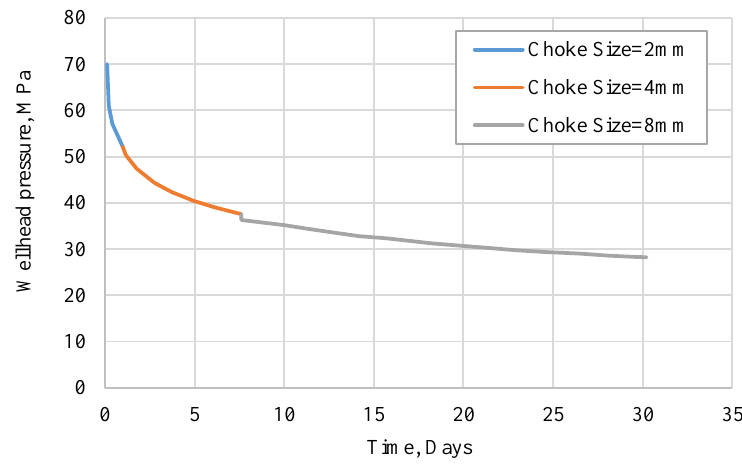
Figure 14—Wellhead pressure curve in forced closure mode.